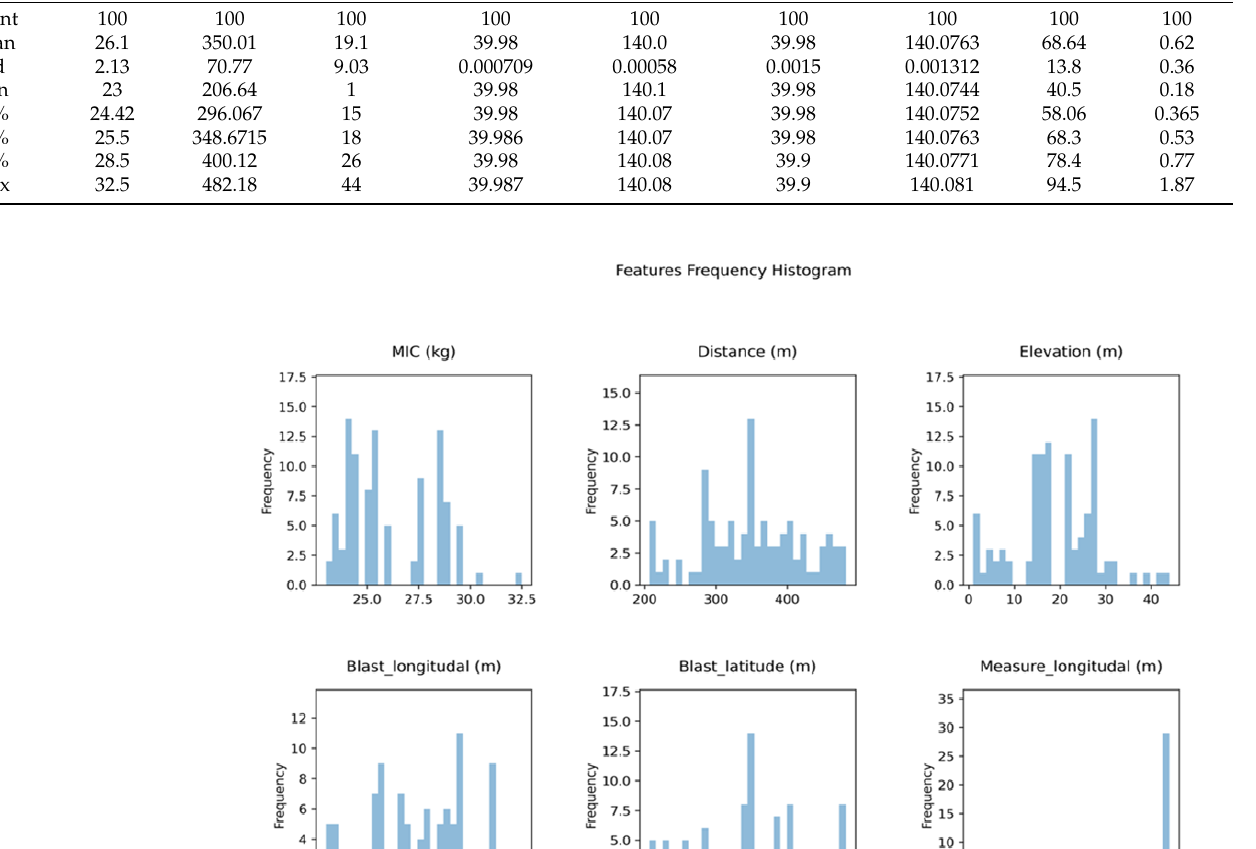
Figure 5. Frequency distribution of the ground vibration dataset. Table 2. Descriptive statistics of the input and output variables.